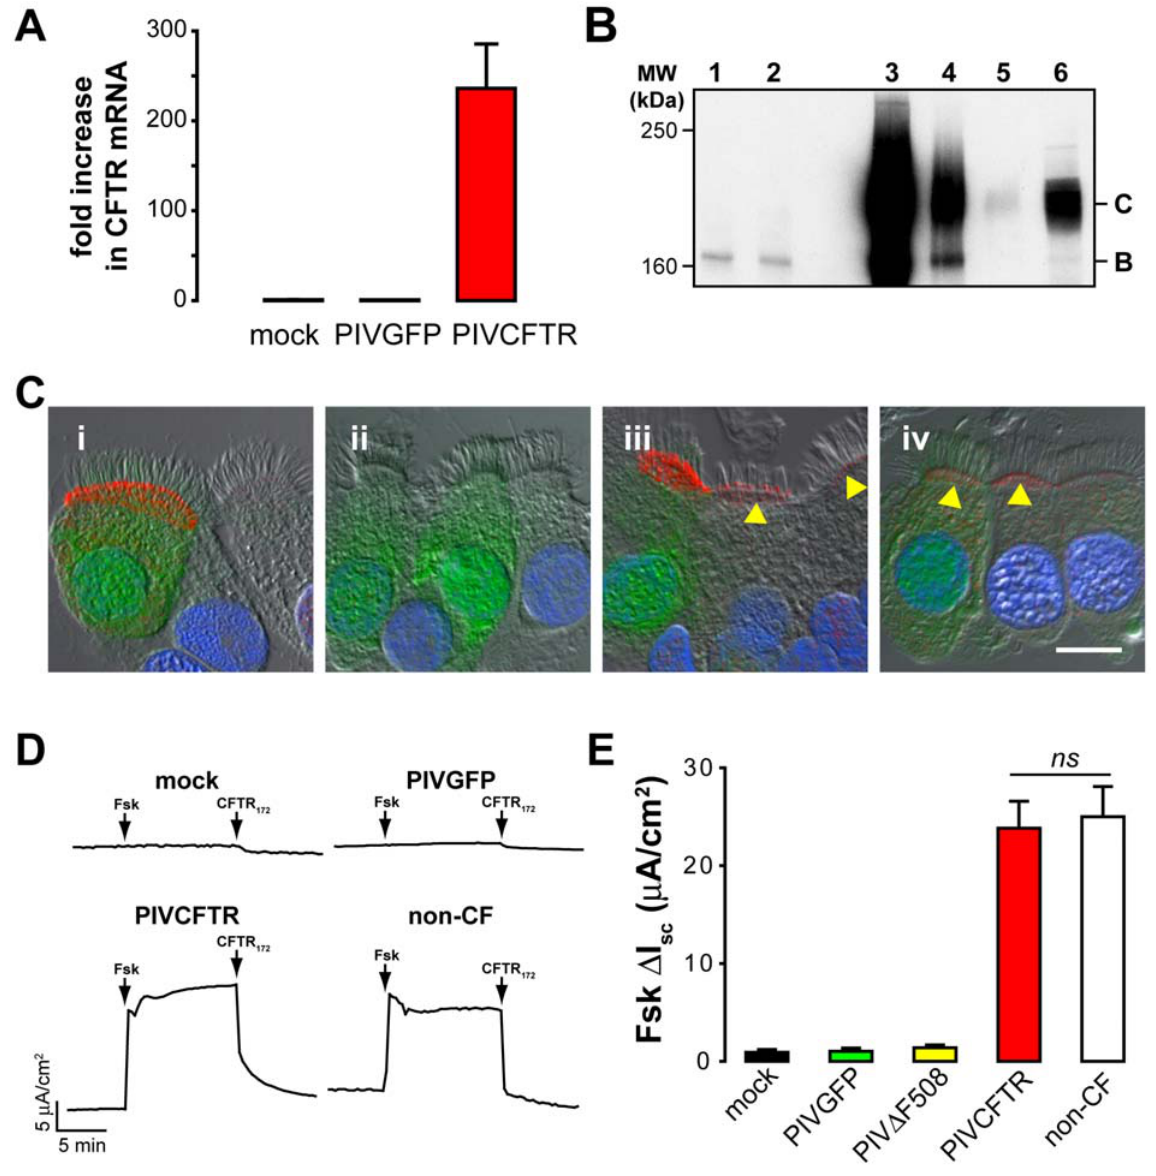
Figure 3. Expression of functional CFTR in CF ciliated cells targeted by PIV. (A) CFTR mRNA levels in CF HAE 48 h after inoculation with PIVGFP or PIVCFTR and relative to mRNA levels in CF HAE mock-inoculated ( n =12). (B) Representative western blot of CFTR protein in lysates of CF HAE 48 h pi with mock (lane 1), PIVGFP (lane 2), and PIVCFTR (lanes 3–5), with lanes 4 and 5 representing serial 10-fold dilution of cell lysates. For comparison, non-CF HAE lysates also were included to detect endogenous CFTR levels (lane 6). Markers indicate the fully glycosylated mature form of CFTR (Band C) and immature nonglycosylated CFTR (Band B). Data are representative of experiments with cells derived from two separate patients. (C) Representative confocal images of CFTR immunoreactivity in CF HAE (i and ii), and non-CF HAE (iii and iv), 48 h after inoculation with PIVGFPCFTR (i and iii) or PIVGFP (ii and iv). CFTR was detected with CFTR monoclonal Ab (clone 596) and secondary Abs conjugated to AlexaFluor 594 (red). CF HAE inoculated with PIVGFPCFTR (i) showed immunolocalization of CFTR at apical domains of ciliated cells that were also GFP-positive, but not in GFP-negative ciliated cells or in CF HAE infected with PIVGFP (ii). Robust apical domain CFTR and GFP were detected in non-CF HAE ciliated cells inoculated with PIVGFPCFTR and endogenous CFTR levels detected in GFP-negative ciliated cells (iii, arrowheads). Endogenous CFTR was detected at the apical membranes of GFP-positive and -negative ciliated cells after inoculation with PIVGFP (iv, arrowheads). Bar represents 5 m m. (D) Representative traces of short-circuit current measurements ( I sc ) from CF HAE 48 h pi by PIVCFTR, PIVGFP, or mock showing post amiloride responses to sequentially added forskolin (Fsk), and CFTR 172 . A representative Fsk-induced I sc response by a non-CF HAE is shown for comparison. No Fsk responses were seen in CF HAE inoculated with PIVGFP or mock, consistent with the absence of CFTR. (E) Summary data for Fsk-activated changes in I sc ( D I sc ) in CF HAE 48 h pi with mock, PIVGFP, PIV D F508CFTR, or PIVCFTR. Fsk responses for non-CF HAE are shown as comparison. CFTR delivery to ciliated cells resulted in restoration of functional Cl 2 channel activity in CF HAE to levels exhibited in non-CF HAE. Each bar represents at least 11 cultures from four different patients. ns denotes not significantly different. Error bars indicate SEM.